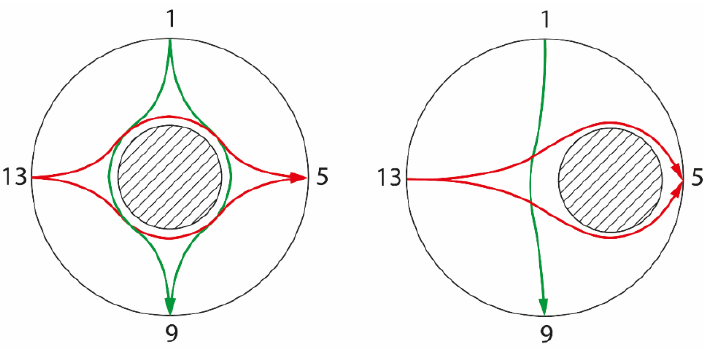
Figure 3. Electric field lines of opposite measurements. ( Left ): centered core, ( right ): core out of center. In green: electric field line when electrode 1 is excited. In red: electric field line when electrode 2 is excited.